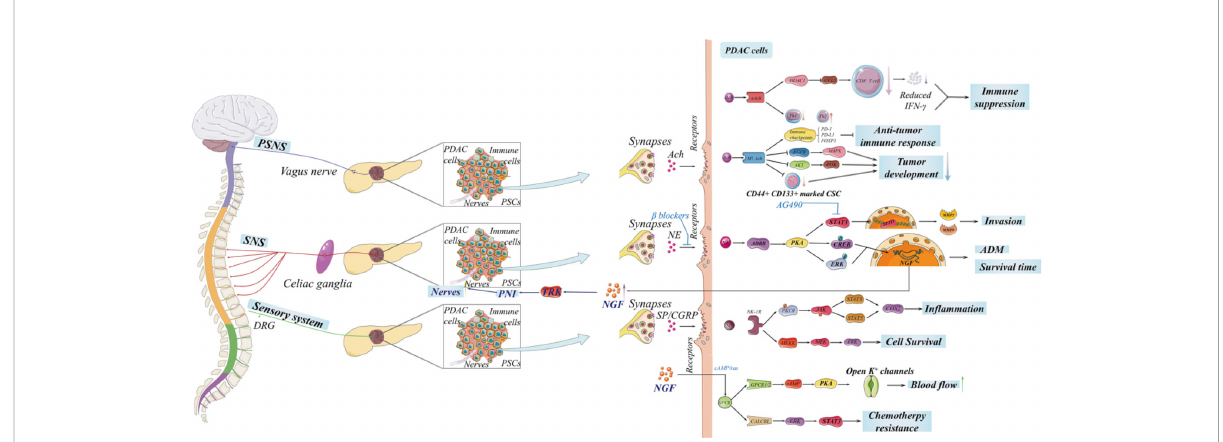
FIGURE 2 The innervation of the pancreas is complex, including the autonomic nervous system and sensory nerves, which is signi fi cant for tumorigenesis and the development of pancreatic ductal adenocarcinoma (PDAC). The sympathetic nervous and sensory systems promote the development of PDAC through neurotransmitters. Notably, neuropathic pain induced by PDAC activates sensory nerves in nerve impulses and then triggers transient receptor potential vanilloid 1 (TRPV1) to secrete substance P and calcitonin gene-related peptide. However, there is an extensive debate on the complicated role of parasympathetic nervous system in PDAC, and the entire signaling network remains to be